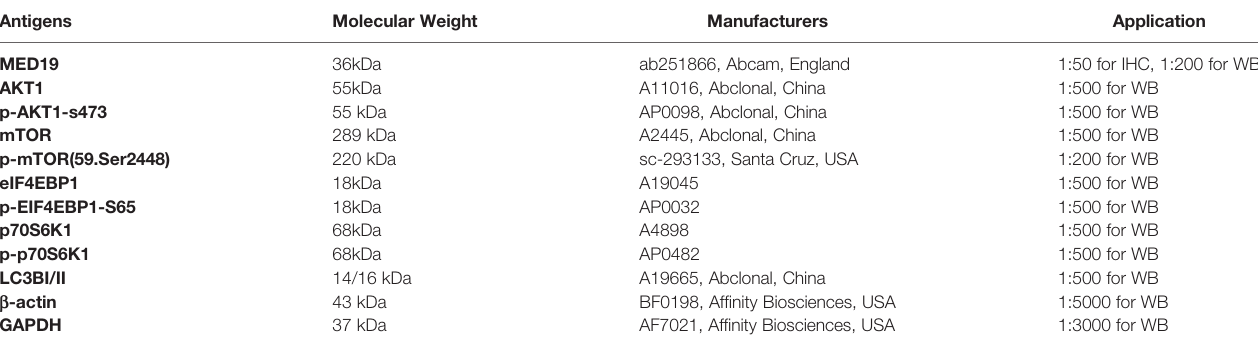
TABLE 1 | Western blot